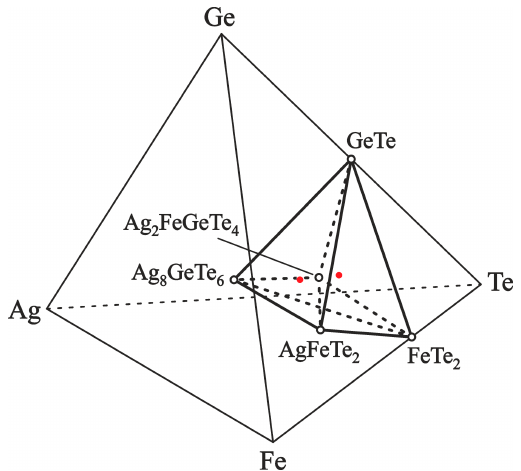
Figure 5. The equilibrium phases in the Fe–Ag–Te–Ge system in the Ag 8 GeTe 6 – FeTe 2 –GeTe–AgFeTe 2 –Ag 8 GeTe 6 part, below 550 K. The dashed and solid tie lines show the 2-phase equilibria, the red closed circle show compositions of positive electrodes of ECCs, and the open circle show compounds. The concentration space’s division into separate regions was performed with the in- formation presented in [36,54,67] as well as this work. Validity of the proposed limits of 4-phase regions is done by the following calculations of thermodynamic values of the Ag 2 FeGeTe 4 compound.